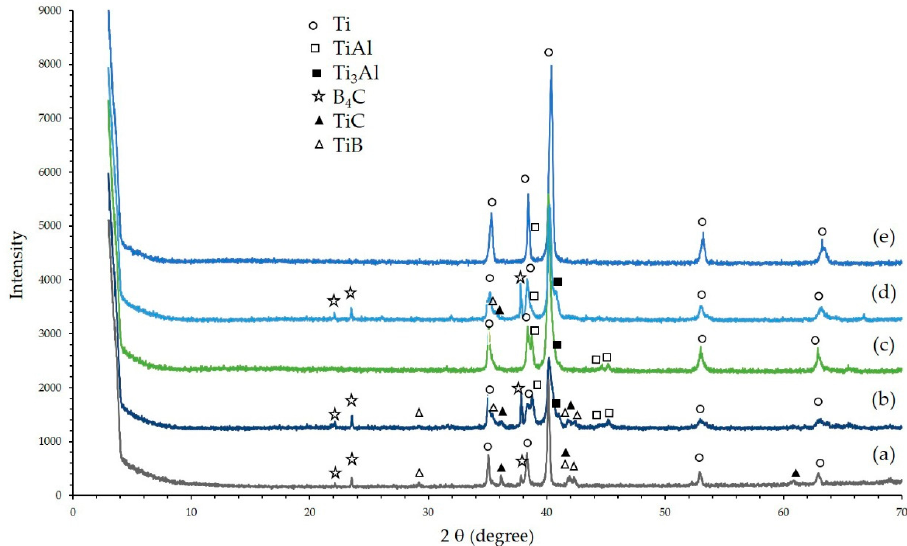
Figure 7. XRD patterns of the specimens: ( a ) Ti + 30 vol. % B 4 C, ( b ) Ti + 30 vol. % B 4 C + 20 vol. % Ti-Al(1), ( c ) Ti + 20 vol. % Ti-Al(1), ( d ) Ti + 30 vol. % B 4 C + 20 vol. % Ti-Al(2) and ( e ) Ti + 20 vol. % Ti- Al(2).